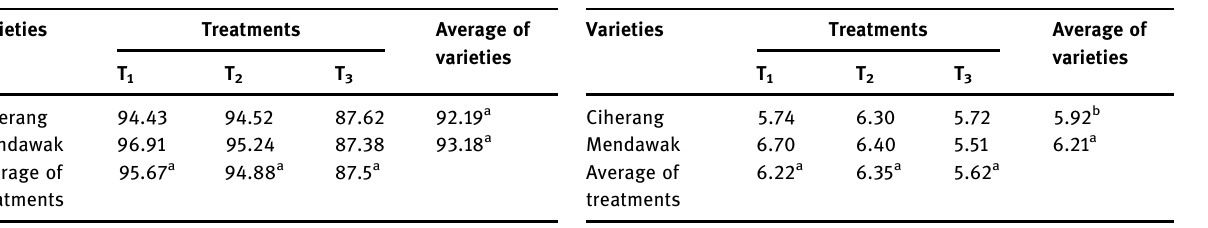
Table 4: Grain yield ( ton/ha )